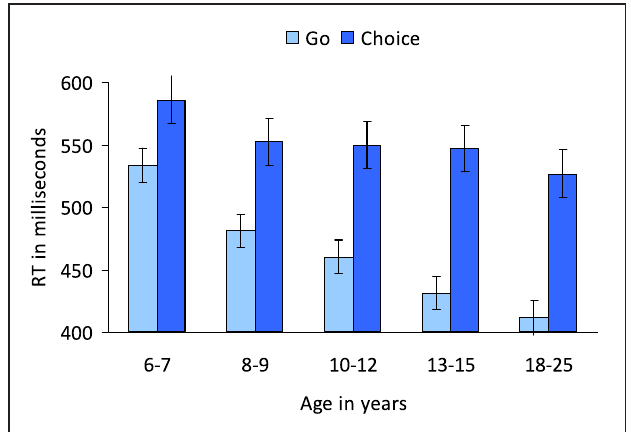
FIGURE 7 | Developmental differences in RTs for the go- and choice-conditions. Participants were instructed to respond to colors and emotion was an irrelevant dimension.